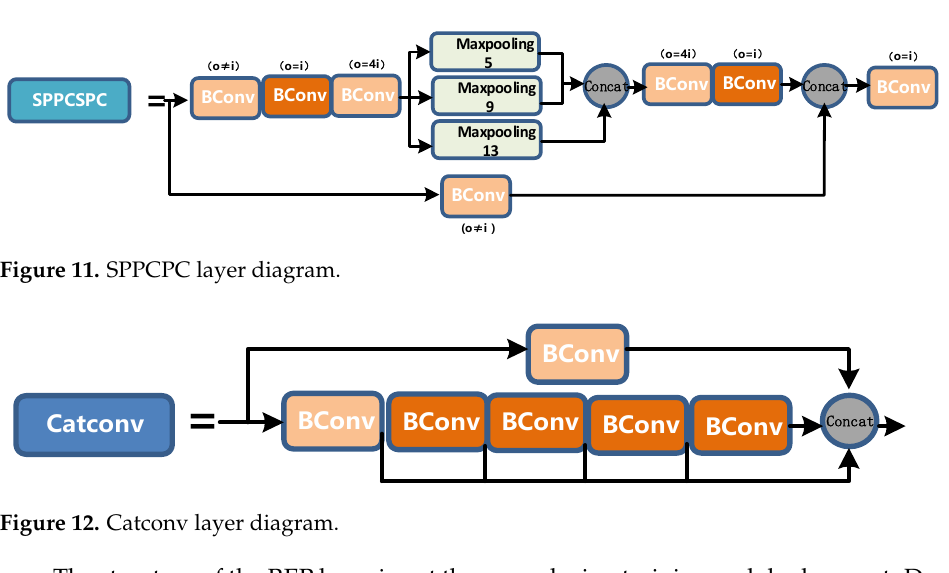
Figure 12. Catconv layer diagram.